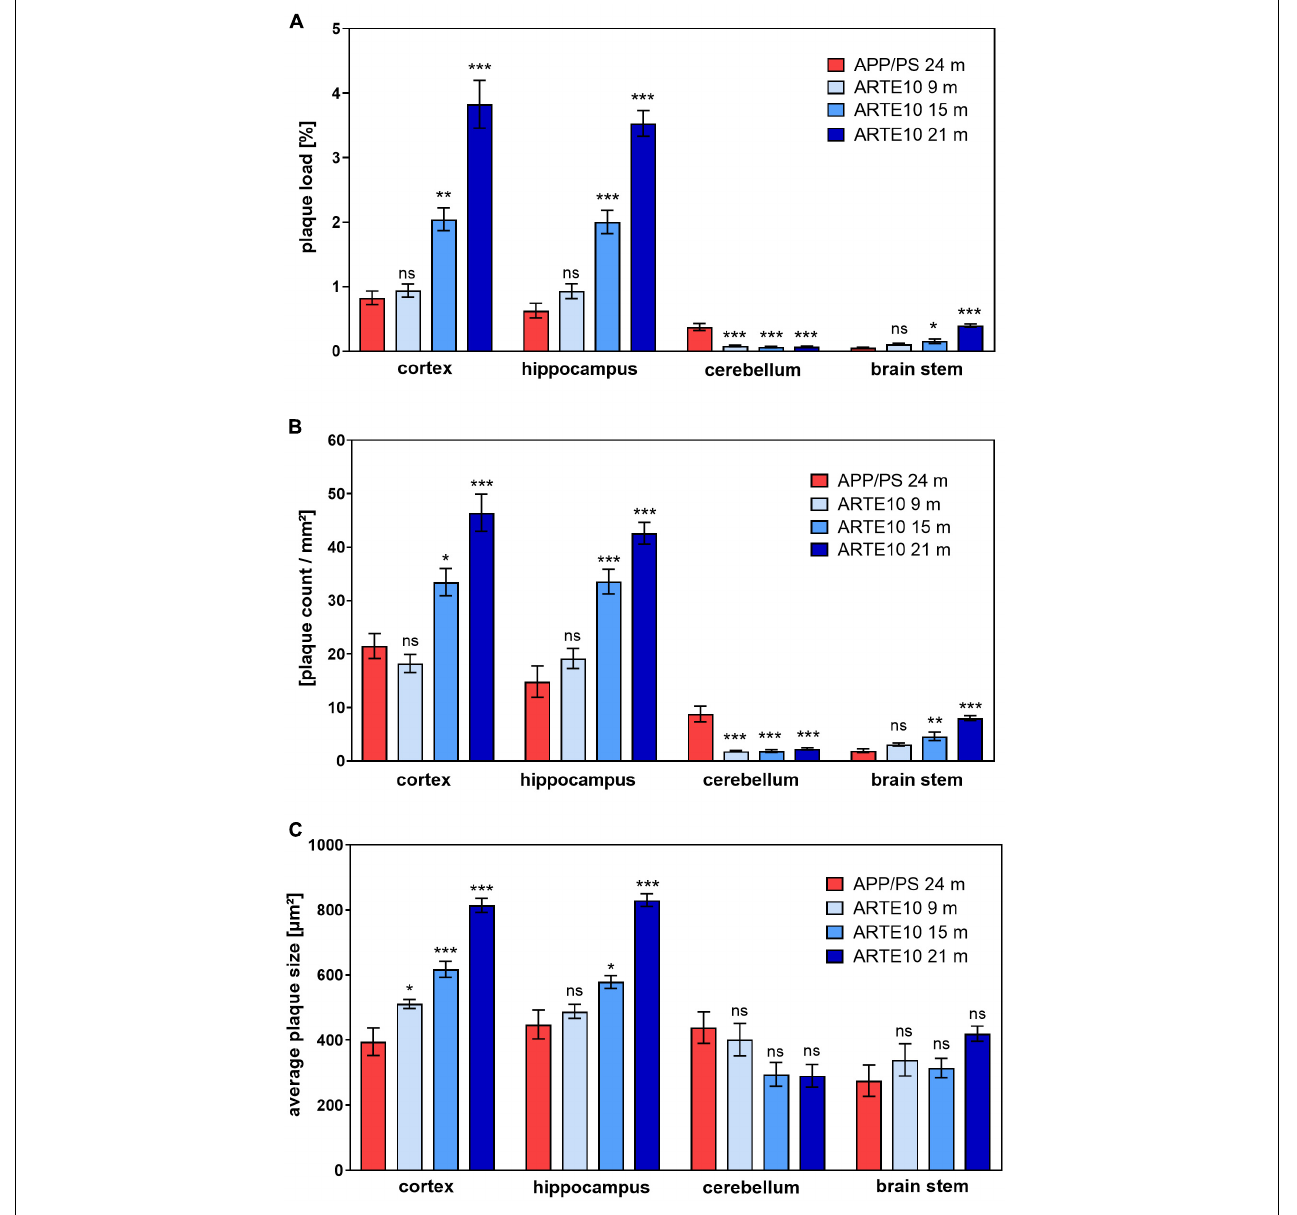
FIGURE 5 | Quantification of amyloid plaque pathology in the brains of ARTE10 and APPswe/PS1 (cid:49) E9 mice. Plaque load (A) , number (B) , and average size (C) of amyloid plaques were quantified on Congo red–stained sagittal brain slices from 24-month-old APPswe/PS1 (cid:49) E9 (APP/PS) and ARTE10 mice of different ages (9–21 months). Data are expressed as mean ± SEM; ns, not significant, * p < 0.05, ** p < 0.001, *** p < 0.0001 vs.